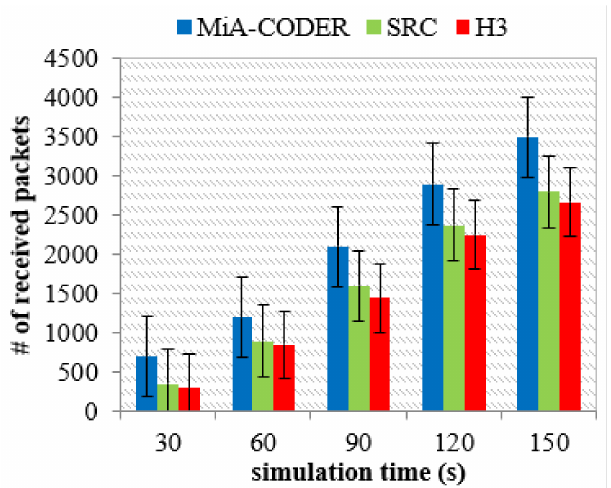
Figure 14. Number of received packets (after coverage hole repair) vs. simulation time.